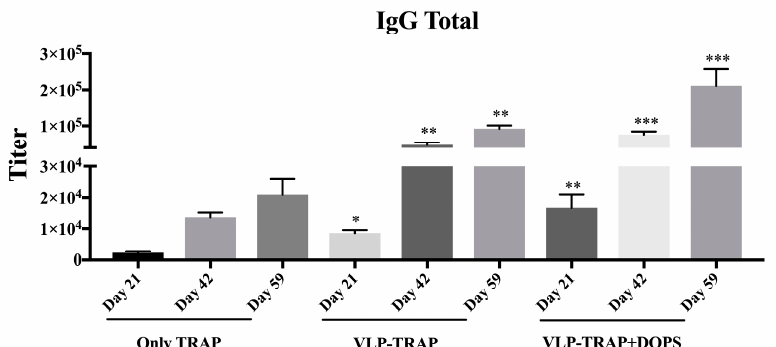
Figure 5. Kinetics of antibody production in CD1 mice. CD1 mice were immunized once every three weeks with TRAP, VLP-TRAP, or VLP-TRAP formulated with DOPS. Blood was taken on Days 21, 42, and 59 and serum antibody levels were determined. Total IgG levels against TRAP are shown in this figure; the group of mice vaccinated with PfTRAP coupled with VLP, as well as when the VLP-PfTRAP was mixed with DOPS adjuvants induced significantly antibody response when compared with the control group. Note: *** p -value < 0.0001; ** p -value < 0.001; * p -value < 0.01.